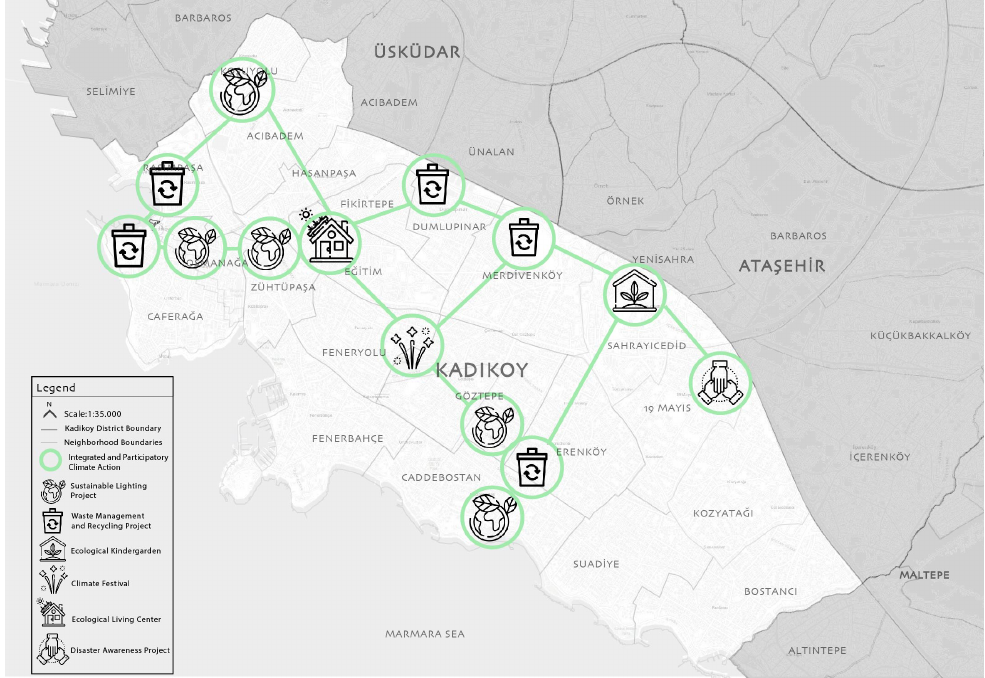
Figure 4. Integrated and Participatory Climate Action Plan of Kadikoy District (map was created based on database of Kadikoy Municipality, 2013